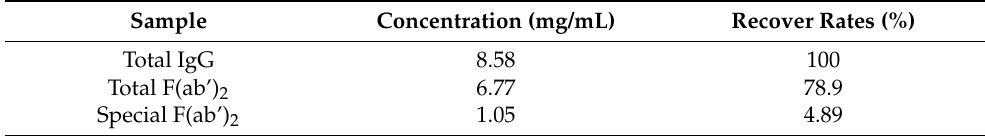
Table 2. Recovery of specific F(ab’) 2 and total F(ab’) 2 .